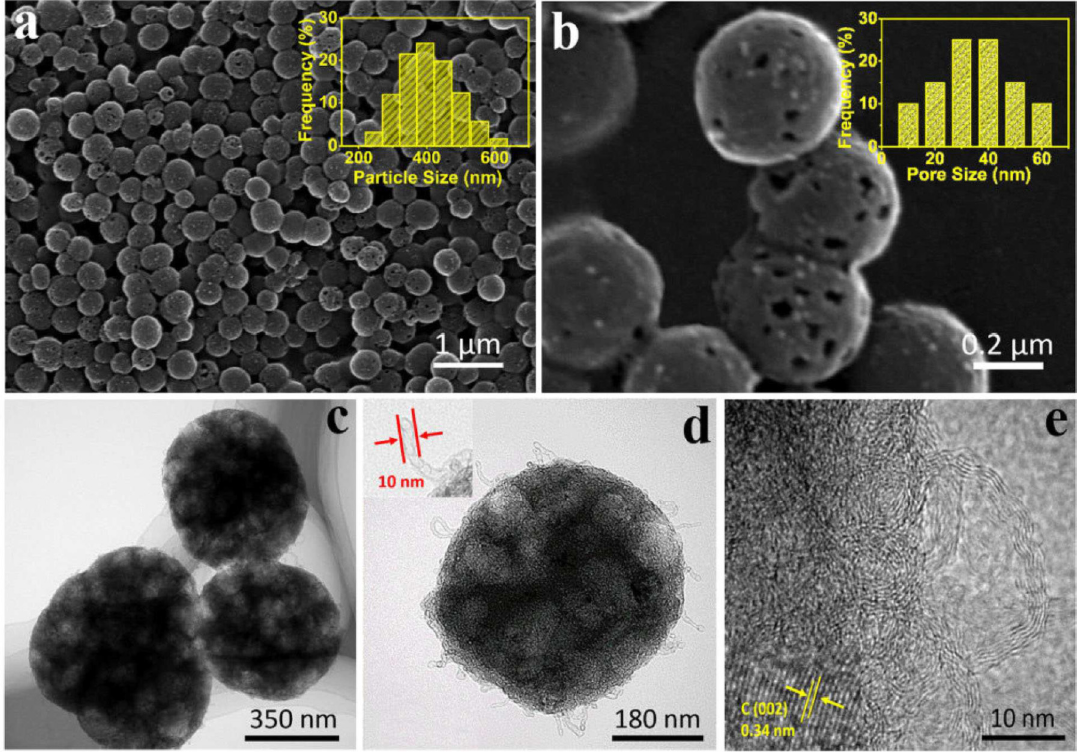
Figure 11. ( a , b ) SEM, ( c , d ) TEM, and ( e ) HR-TEM images of N / Co-co-doped mesoporous carbon microspheres. Reprinted with permission from ref. [98]. Copyright (2019) John Wiley and Sons.